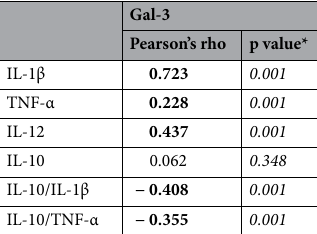
Table 3. Correlation between Gal-3 and pro- and anti-inflammatory cytokines. Significant values are in bold and italics. *p value < 0.05 was considered statistically significant.